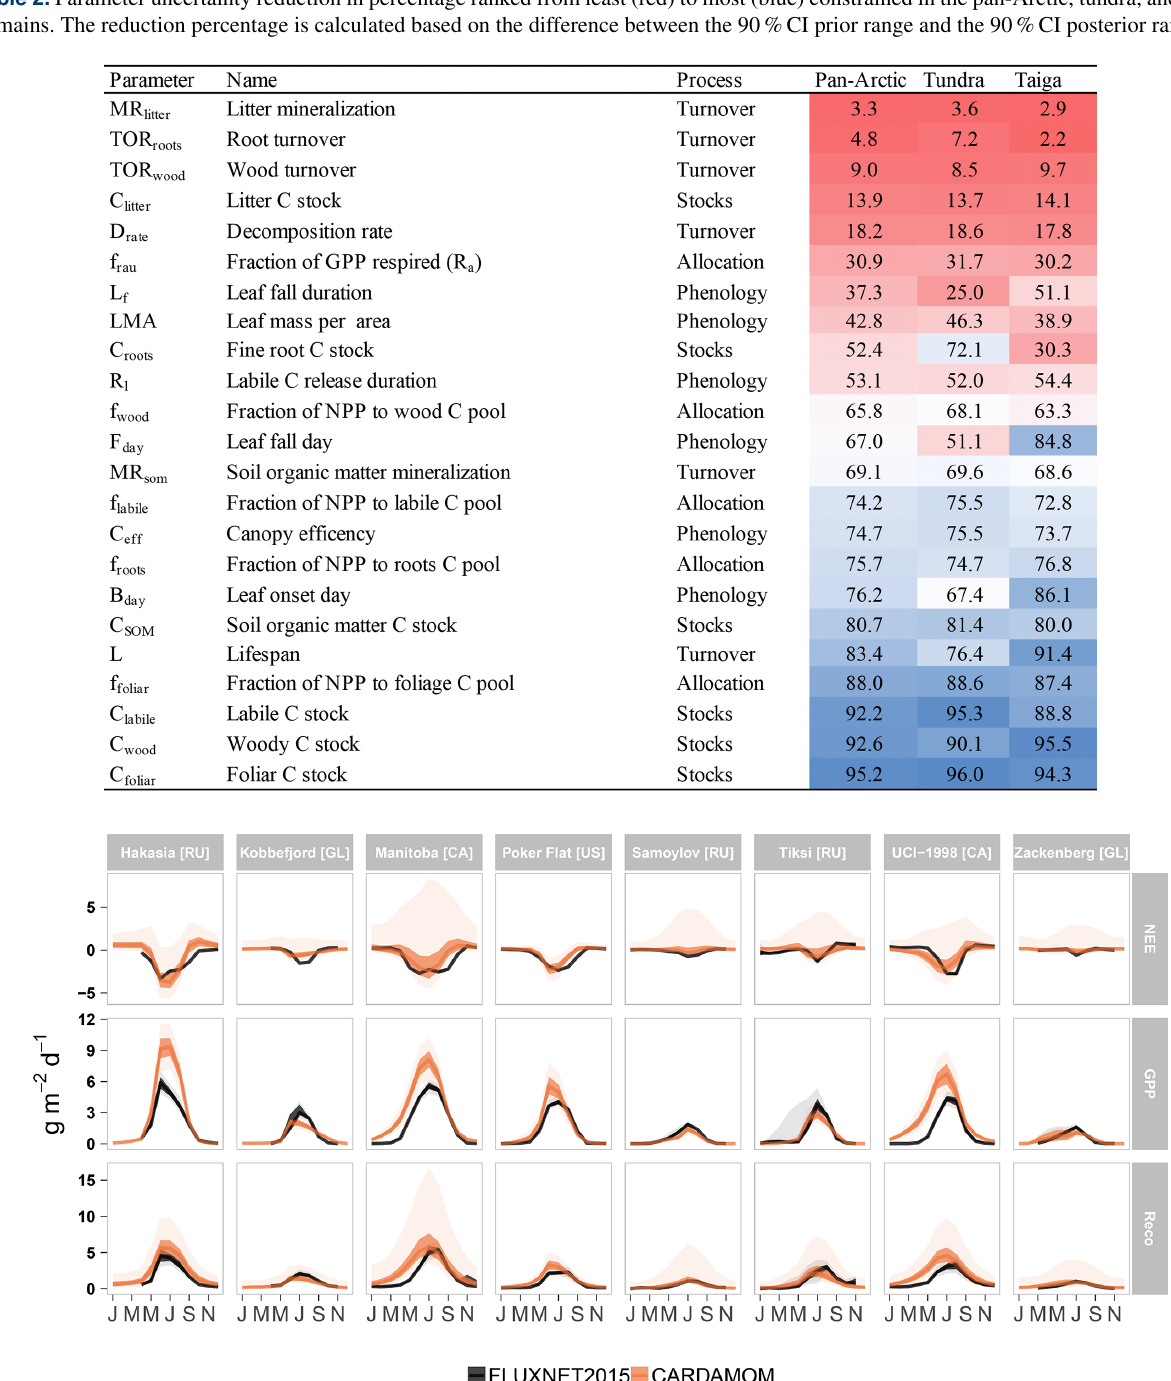
Table 2. Parameter uncertainty reduction in percentage ranked from least (red) to most (blue) constrained in the pan-Arctic, tundra, and taiga